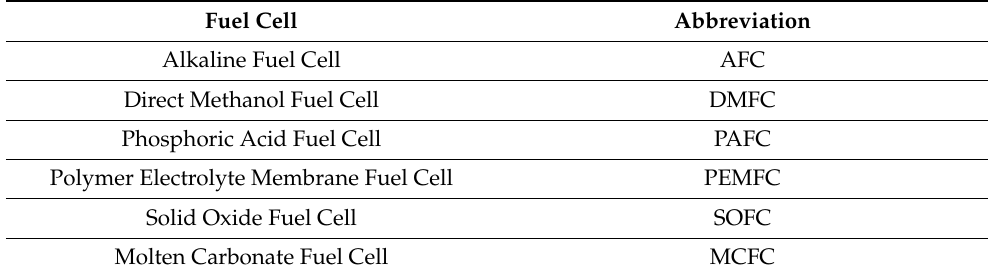
Table 1. Common types of fuel cells.